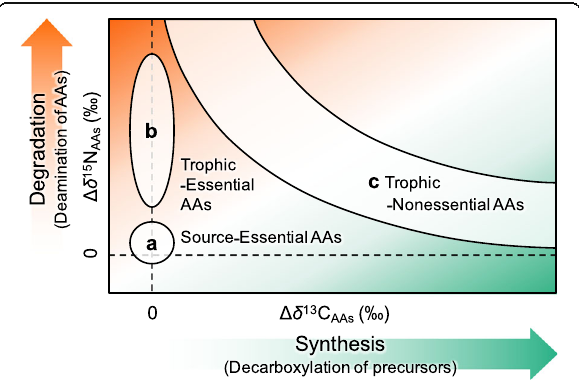
Fig. 5 Possible classification of amino acids: a source-essential, b trophic-essential, and c trophic-nonessential on the cross-plot of the Δ δ 15 N and Δ δ 13 C values